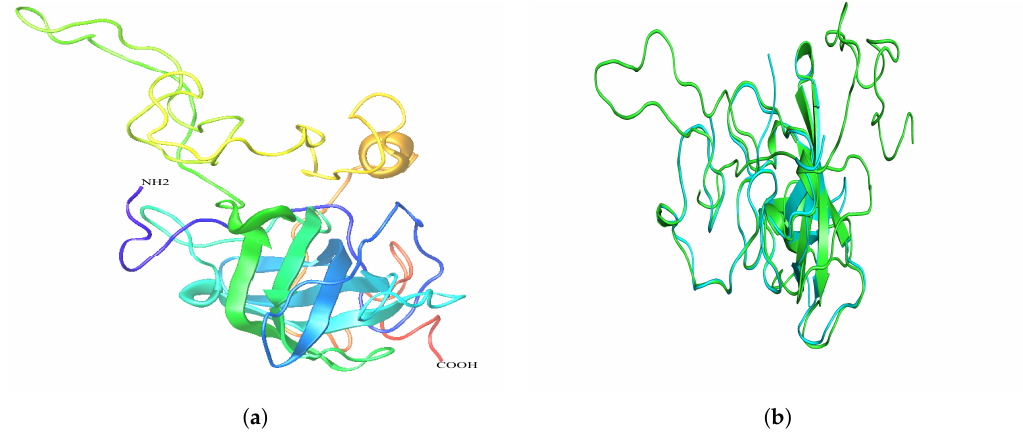
Figure 11. Modeled 3D structures. ( a ) The 3D structure of the cLin-28 protein. ( b ) Stereo ribbon representation of the predicted 3D structure model of the cLin-28 protein (cyan) and the superimposition with the human Lin-28 protein